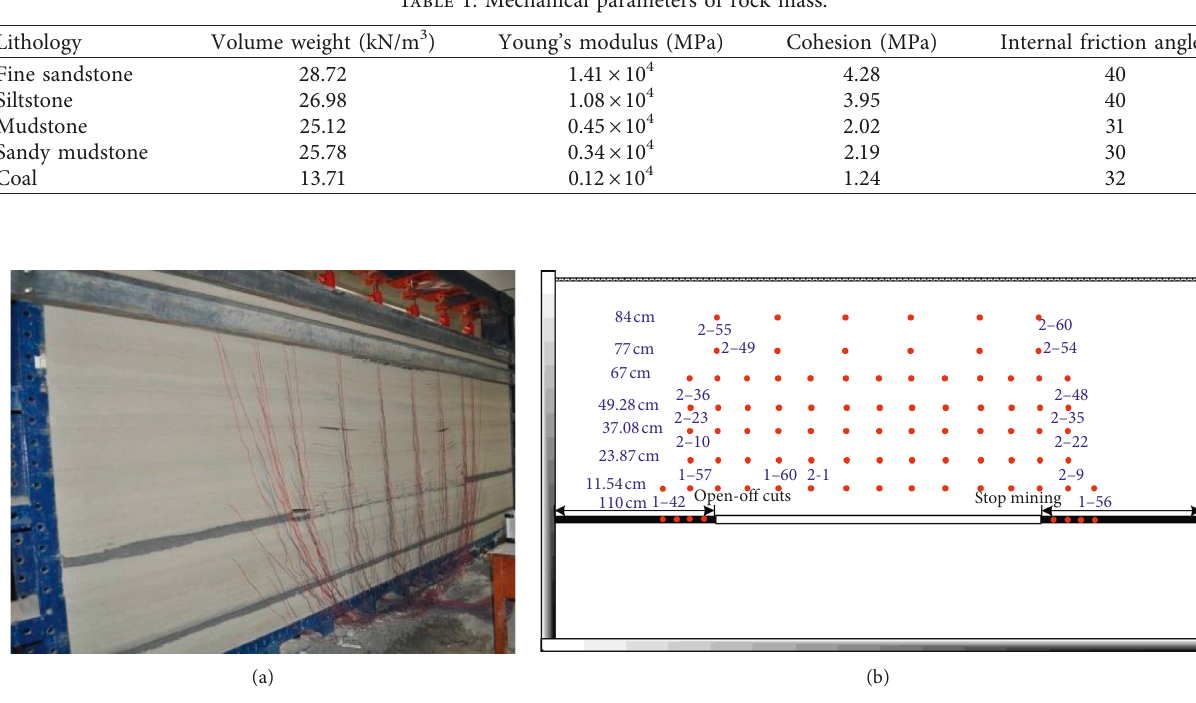
Figure 3: Similar simulation experiment device and measuring point